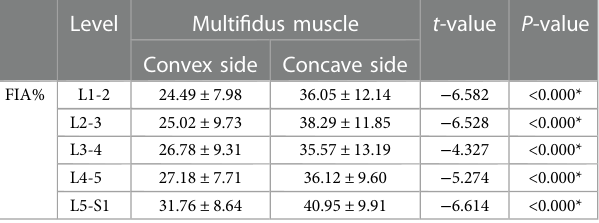
TABLE 3 The FIA% of the multi fi dus muscle on the concave and convex sides in the PI-LL mismatch group. Level Multi fi dus muscle t- value P -value Convex side Concave side